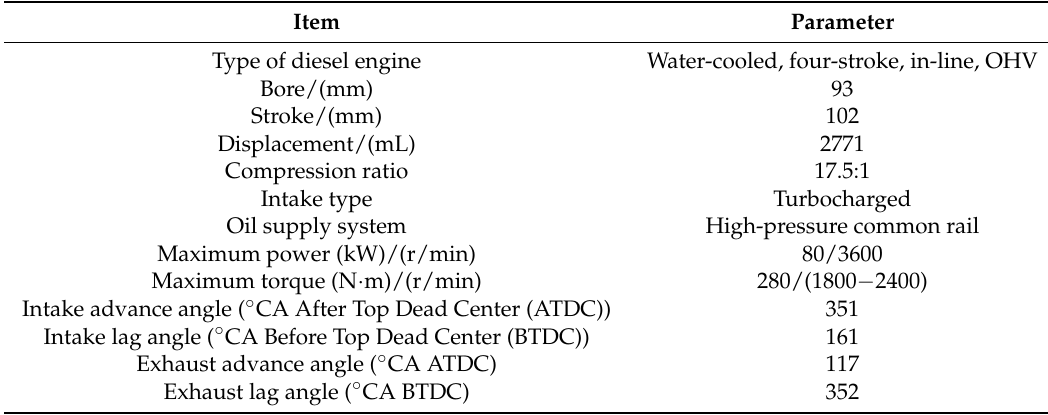
Figure 2. Engine test system. Table 1. Main parameters of original diesel engine.